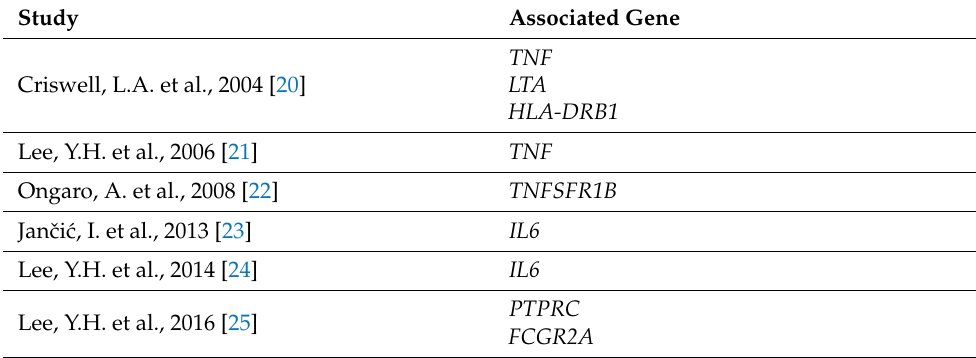
Table 2. DNA biomarkers of response to anti-TNF therapy in RA.